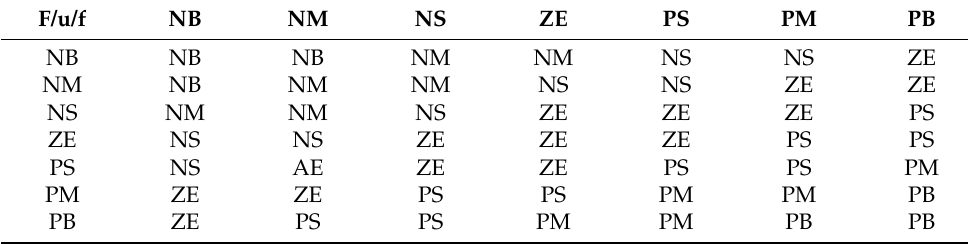
Table 3. Fuzzy rules of ∆ k i .